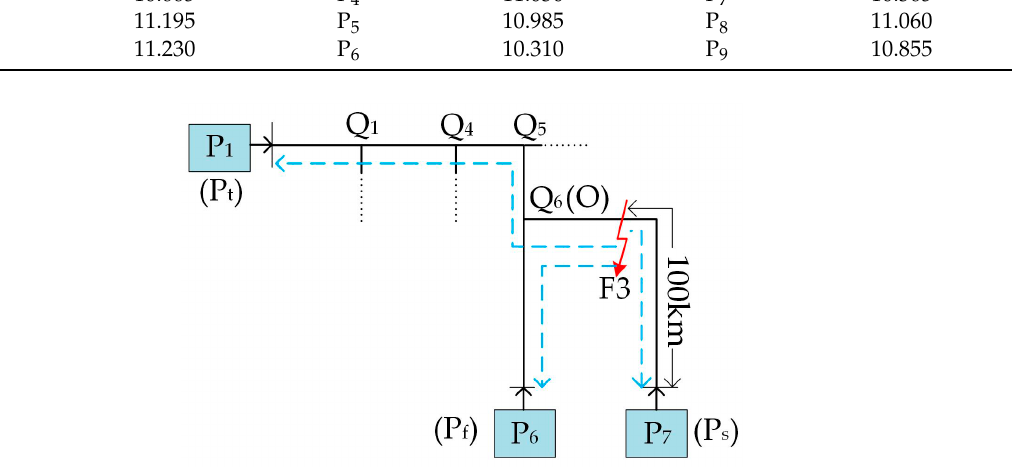
Figure 12. Identified three-terminal fault section for fault F3.